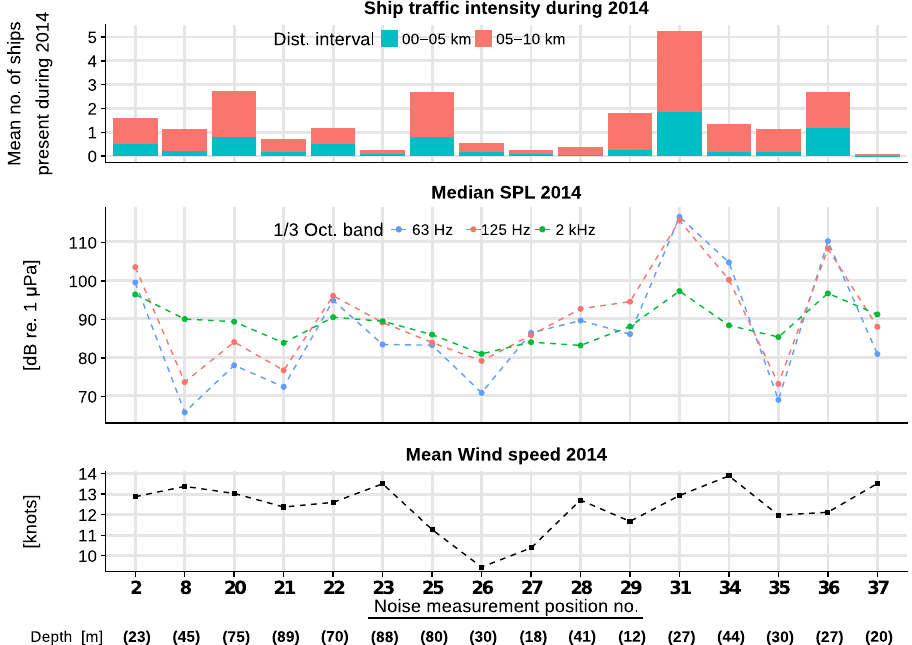
Figure 7. Median SPL one-third octave band levels at all monitoring locations in the middle along with the mean values of the ship traffic intensity on the top, mean wind speeds and the water depths in the bottom. The dashed lines joining the points are to be considered as aids for visualising the data and not as indicating the intermediate values between the locations. The wind speed data originates is the SMHI open-access data from MESAN weather analysis